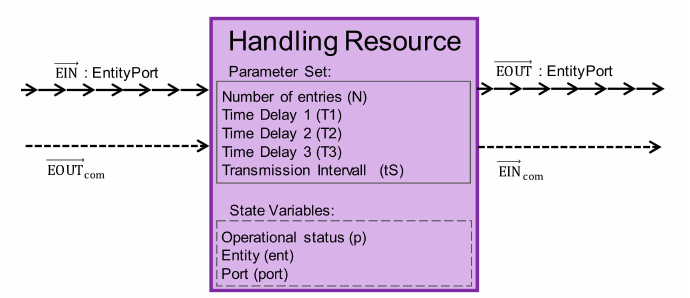
Figure 4. Crane component which is implemented as a handling resource